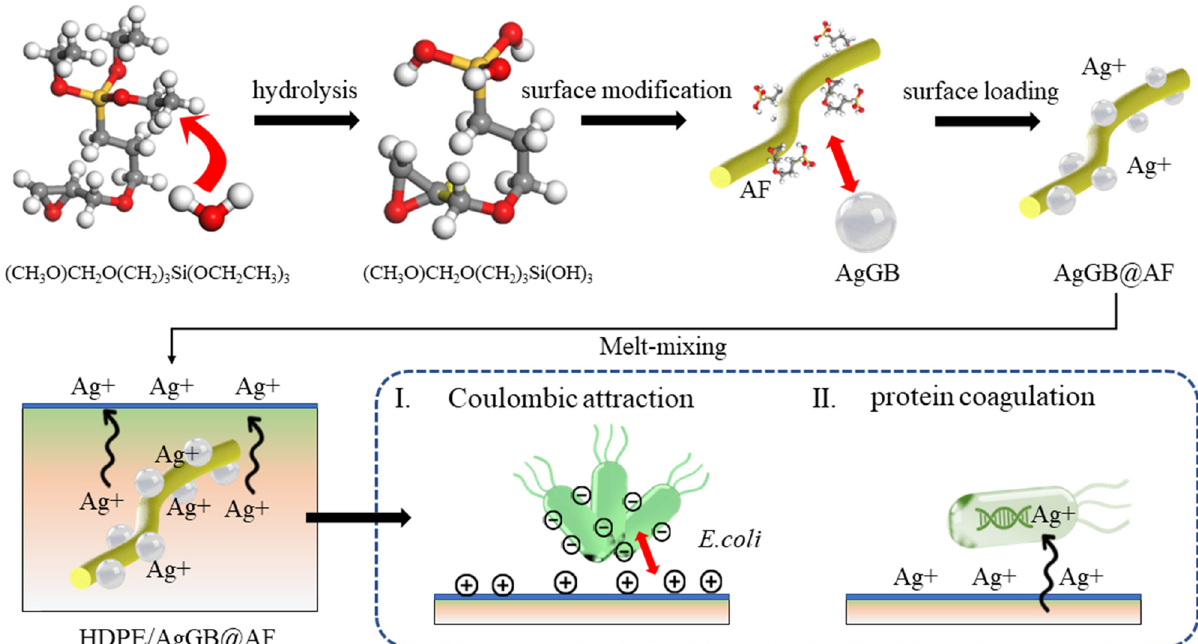
Figure 9: Schematic of mechanisms for preparing AgGB@AF and antibacterial of HDPE